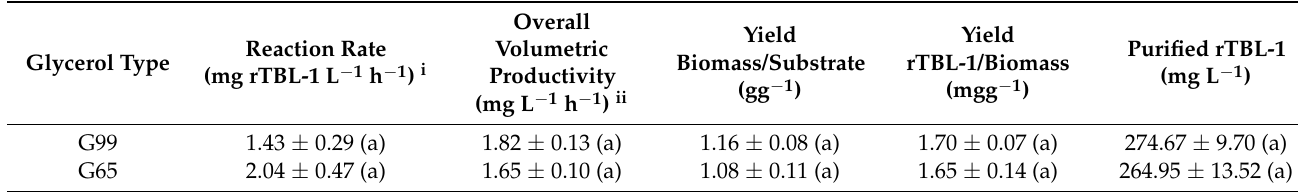
Table 4. Substrate effect on rTBL-1 production using P. pastoris in a fed-batch system at 1000 rpm, pH 4.5, and 1 vvm using G99 or